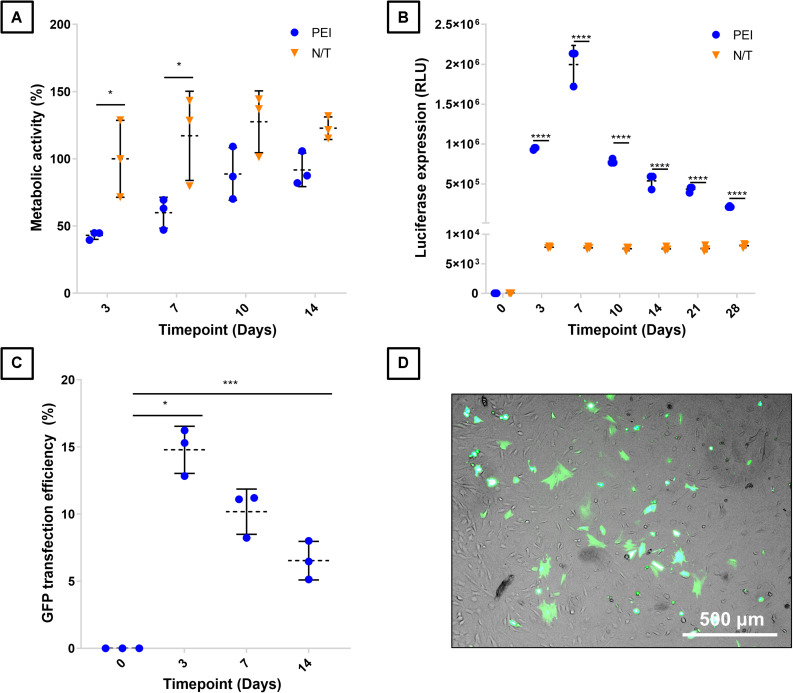
Characterization of BM-MSCs transfection with PEI-pDNA nanoparticles. BM-MSCs were transfected with PEI-GLuc and compared to non-transfected (N/T) in terms of (A) metabolic activity as a surrogate marker of cell viability, and (B) in terms of luciferase expression. BM-MSCs were also transfected with pGFP nanoparticles to determine their (C) transfection efficiency over time, while (D) brightfield and fluorescence microscopy image overlay shows GFP+, successfully transfected cells. *, ***, and **** denotes p < 0.05, 0.001, and 0.0001 respectively. Data plotted represents mean ± standard deviation, n = 3.